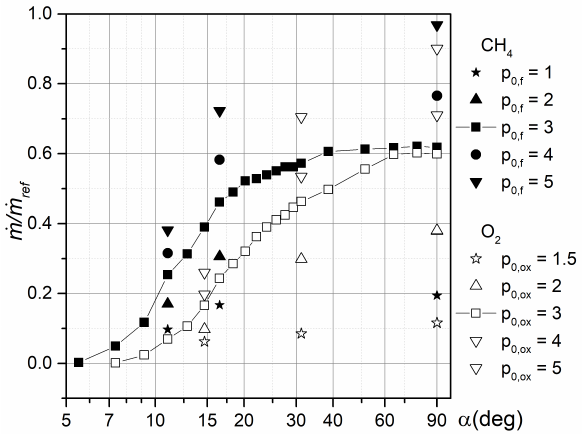
Figure 4. Relative mass flow rate as a function of the valves opening angle α and line total pressure p 0